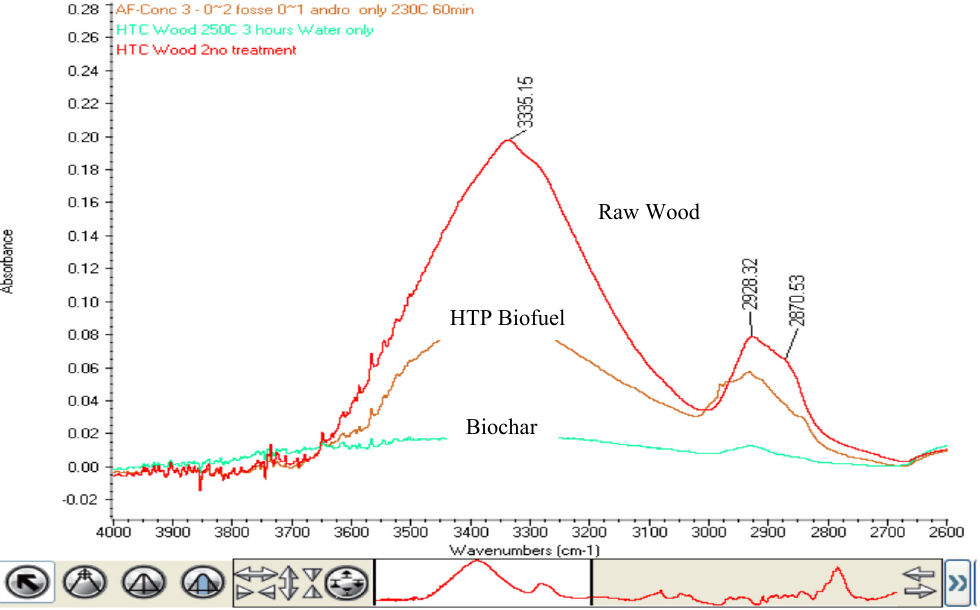
Figure 4. FTIR spectrum of OH region of MID INFRARED SPECTRUM. The three samples are raw wood, biofuel from hydrothermal polymerization (HTP) catalytic process and biochar from hydrothermal carbonization (HTC) process where no catalyst is used.